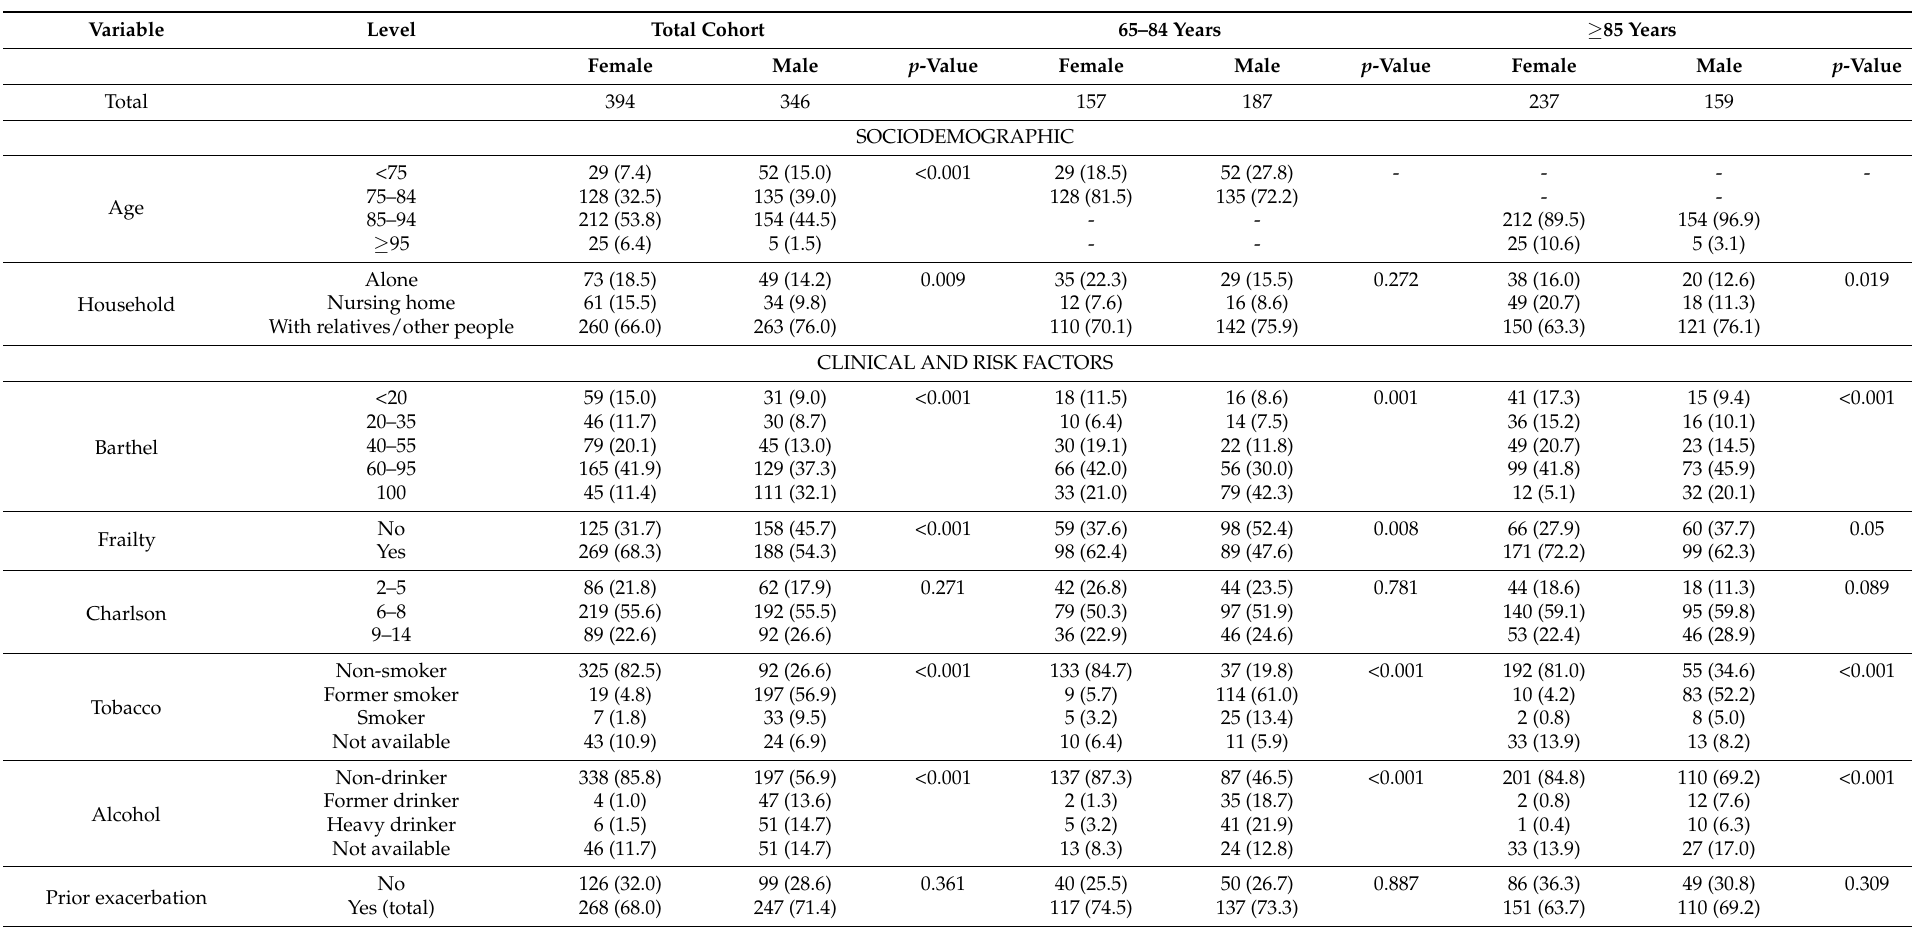
Table 1. Clinical variables, medication, and adverse outcomes in older patients hospitalized for acute exacerbation of chronic disease. Categorical variables: N (vertical %), chi-squared test. Numerical variable: Median (IQ range), Wilcoxon test. * Percentage and p -value calculated over the alive cohort. ** Percentage and p -value calculated over the deceased cohort. PIM: Potentially inappropriate medication. PPO: Potential prescribing